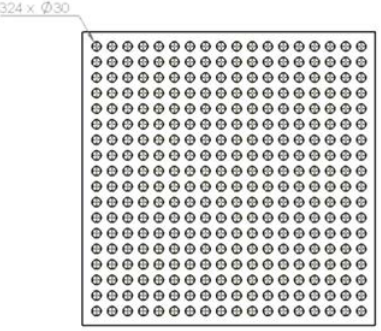
Figure 3. Perforated plate.